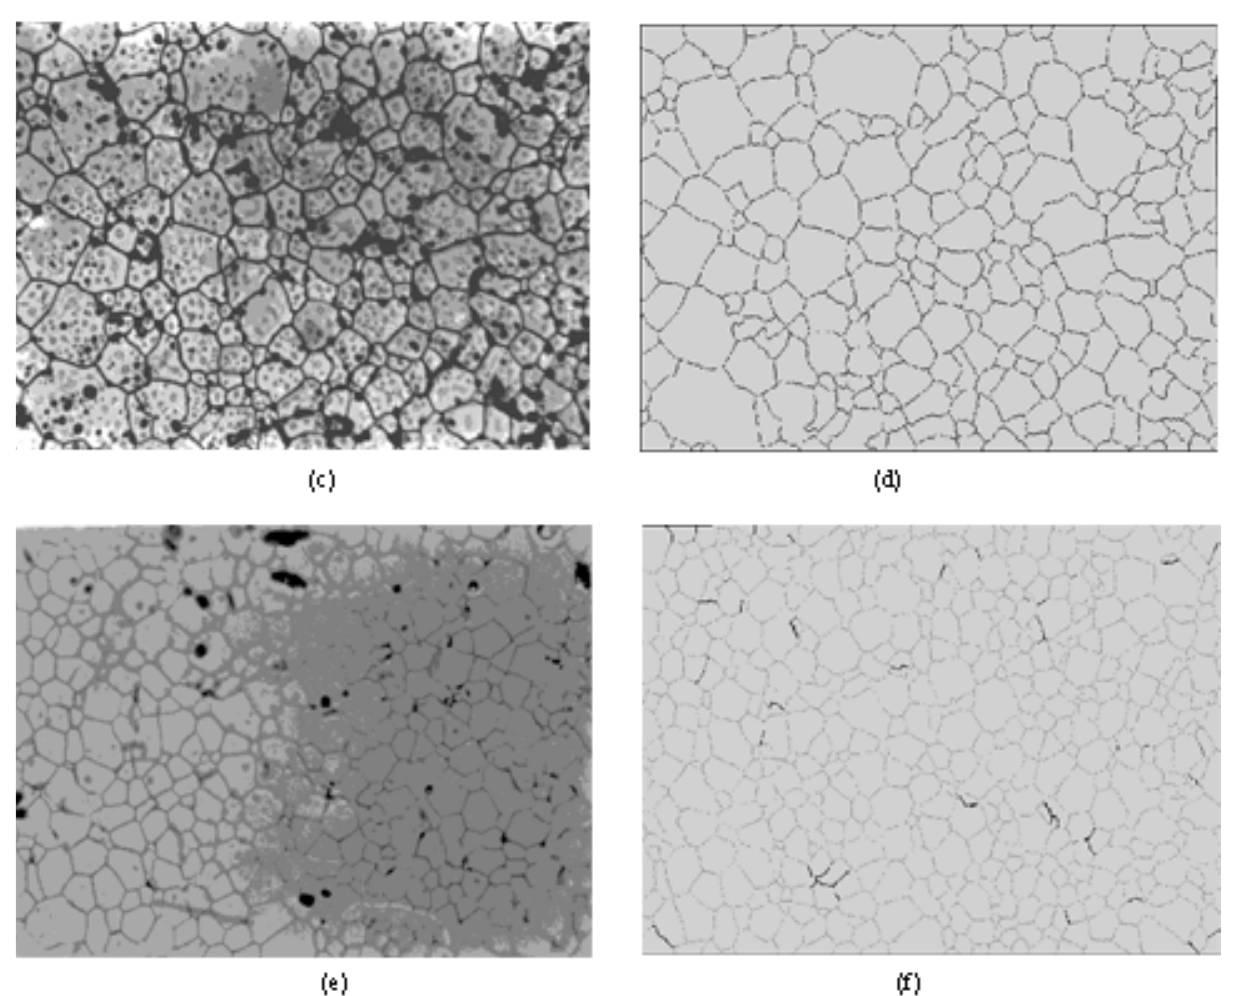
Figure 7 (cont). ABA transform segmentation for three uranium oxide samples: (a), (c) and (e) are original noisy images, (b), (d) and (f) are ABA transform segmented